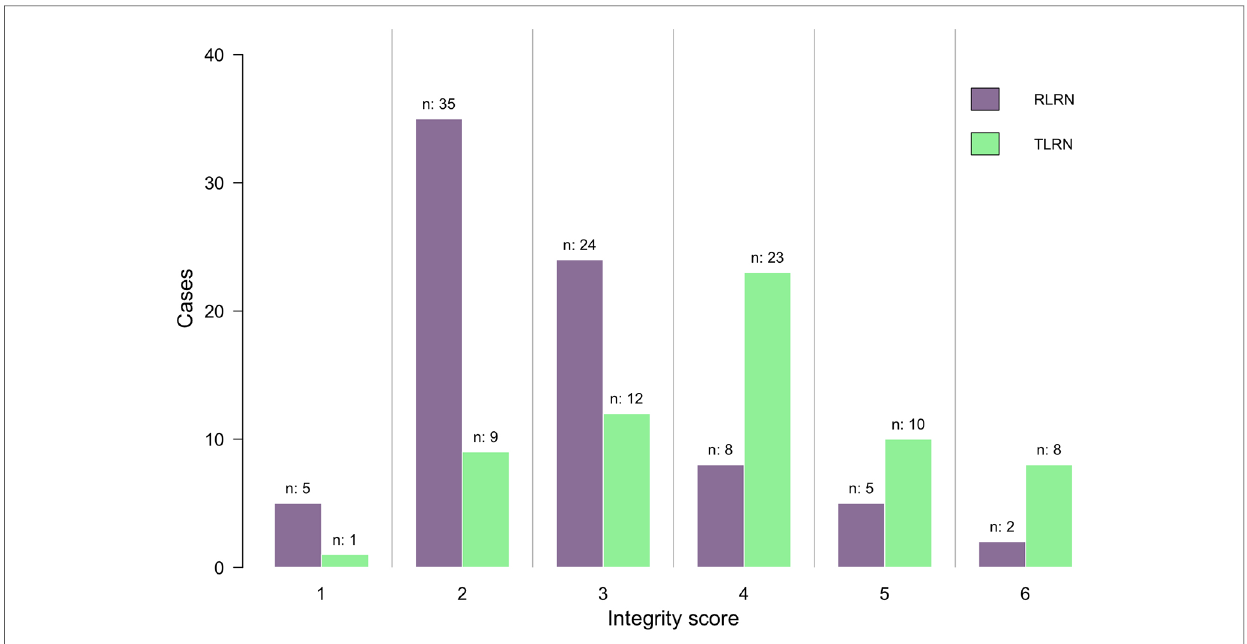
FIGURE 2 Distribution of the integrity score between RLRN group and TLRN group. RLRN retroperitoneal radical nephrectomy, TLRN transperitoneal radical